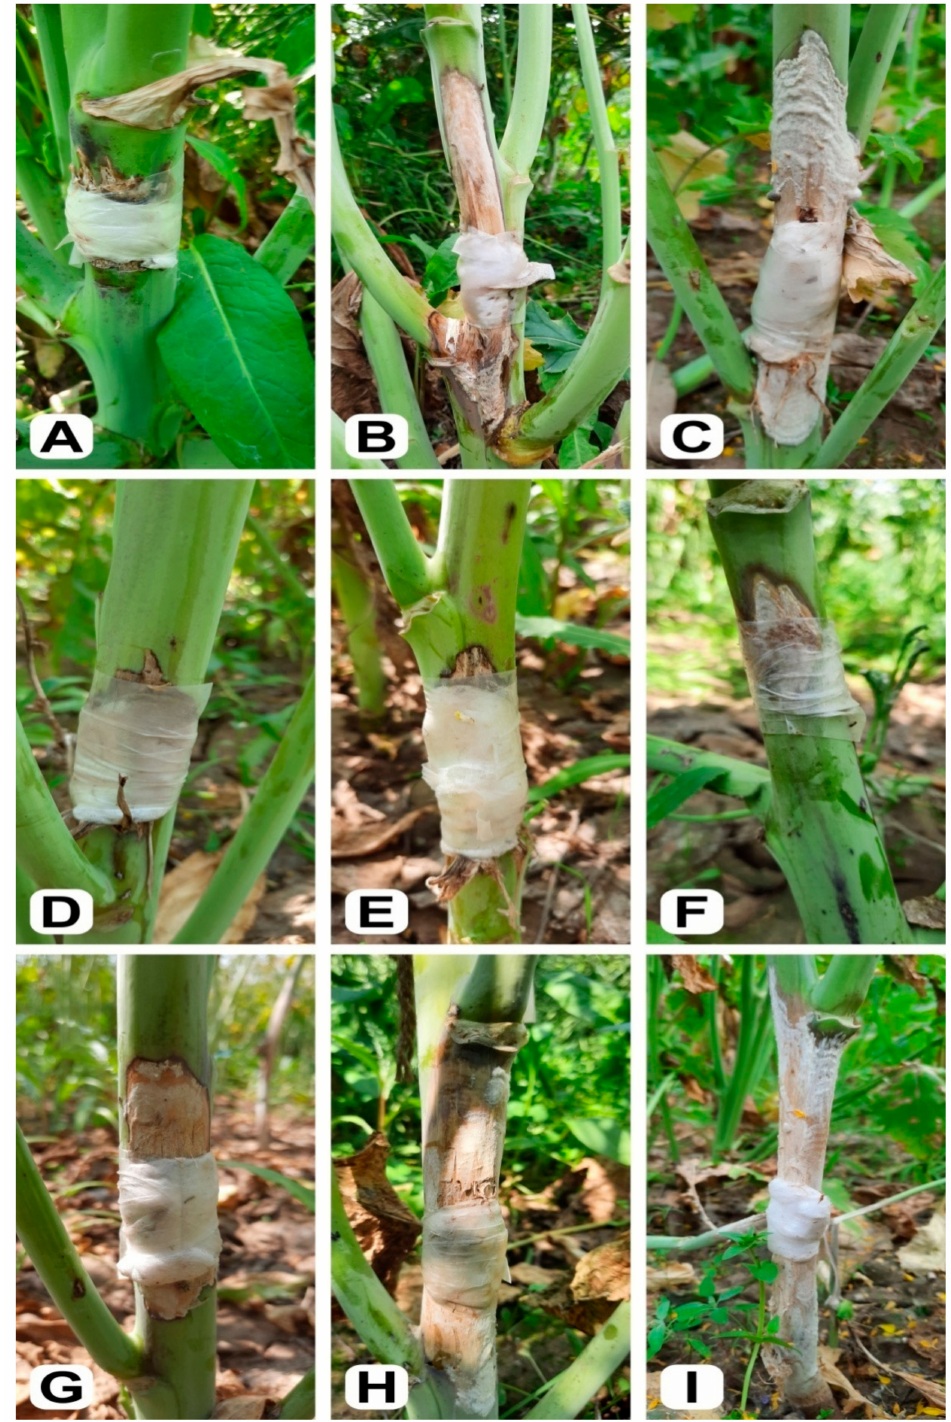
Figure 3. Sclerotinia sclerotiorum response exhibited by parental genotypes. ( A ) Resistant parent RH 1222-28 with lesion length <4.0 cm; ( B ) susceptible parents EC 766300 and ( C ) EC 766123 with lesion length > 9.0 cm; disease response in F 2 plants; ( D , E ) highly resistant with lesion length < 2.5 cm; ( F ) resistant response with lesion length between 2.6 to 5.0 cm; ( G ) moderately resistant response with lesion length between 5.0 to 7.5 cm; ( H ) susceptible response with lesion length between 7.6 to 10.0 cm; ( I ) highly susceptible response with lesion length > 10.0 cm. The F 1 , F 2 , BC 1 P 1 , and BC 1 P 2 generations in both crosses fall within the parental range except for C-II, where BC 1 P 2 expressed a significantly higher mean lesion length